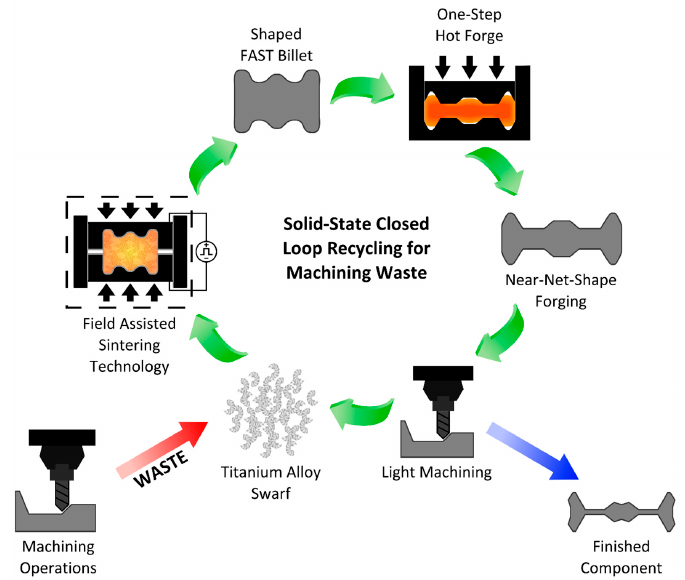
Figure 1. Schematic representing the solid-state closed-loop recycling approach, incorporating the FAST- forge process (where FAST stands for field assisted sintering technology), for sustainable production of low-cost titanium alloy components for multiple sectors.